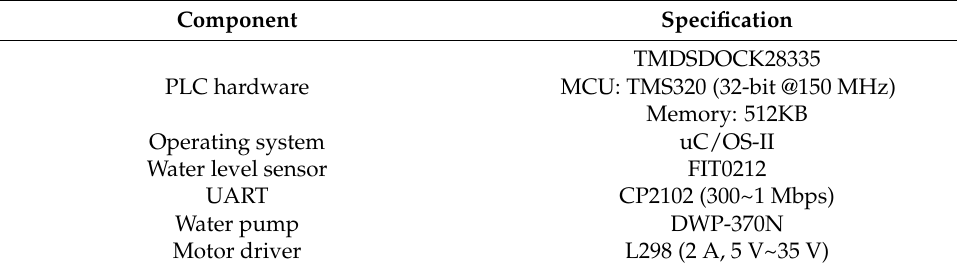
Table 1. Hardware